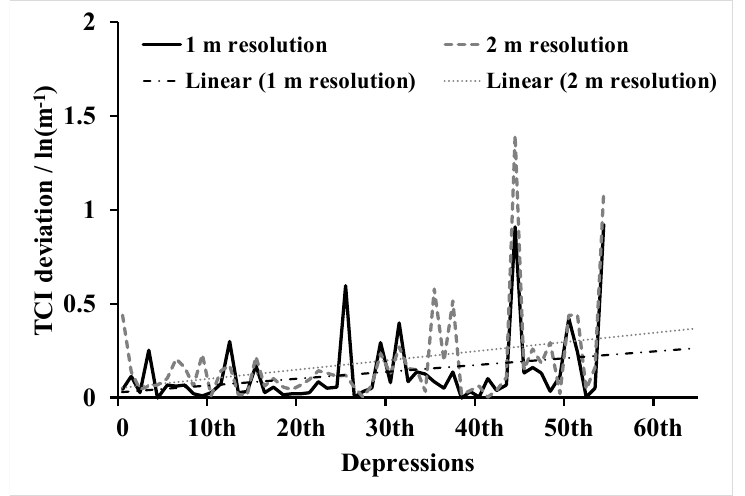
Figure 8. The pattern of TCI deviations of depressions at resolutions of 1 and 2 m. All 55 qualified depressions are ranked by area in descending order. ‘Linear’ in the legend means the linear trend of TCI values.